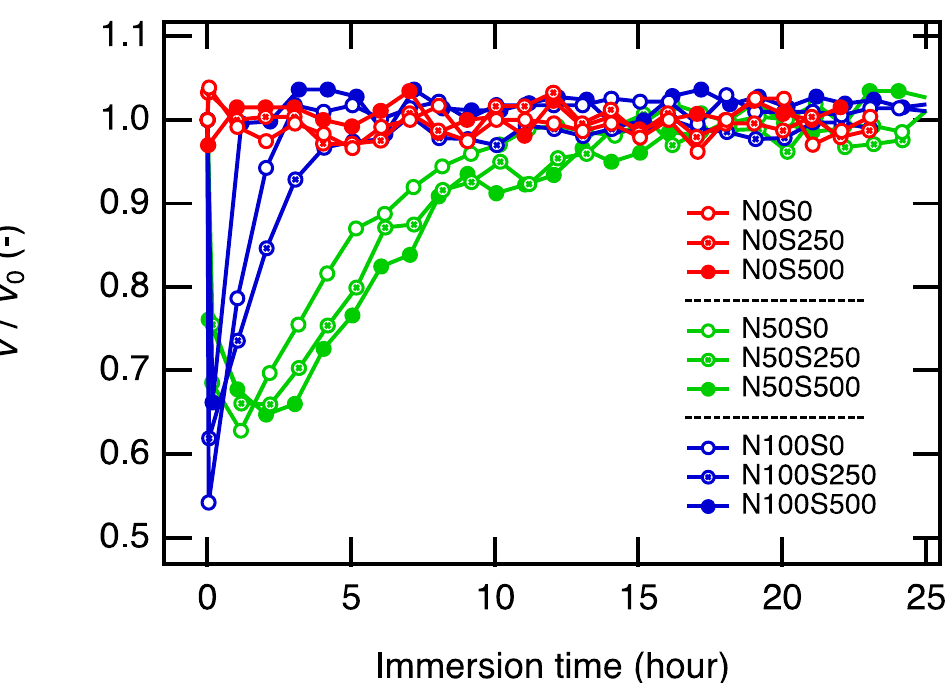
Figure 2. Volume change of the as ‐ prepared N0S0 gels immersed in nine PAA solutions with different neutralization degrees (N: 0, 50, and 100%) and salt concentrations (S: 0, 250, and 500 mM). All PAA solutions have the same polymer concentration as the as ‐ prepared gel (15 wt%). The volume of immersed gels ( V ) was normalized by their as ‐ prepared volume ( V 0 ).